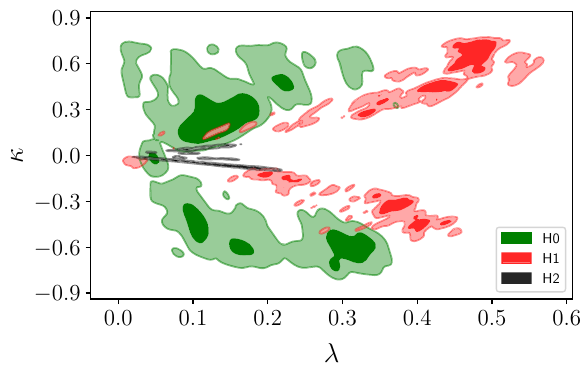
Fig. 5 Marginalised posterior distribution for the NMSSM parameters λ and κ . The green ( H 0), red ( H 1) and black ( H 2) regions represent the hypotheses H 1 , H 1 and H 2 , respectively. Inner and outer contours respectively enclose 68% and 98% Bayesian credibility